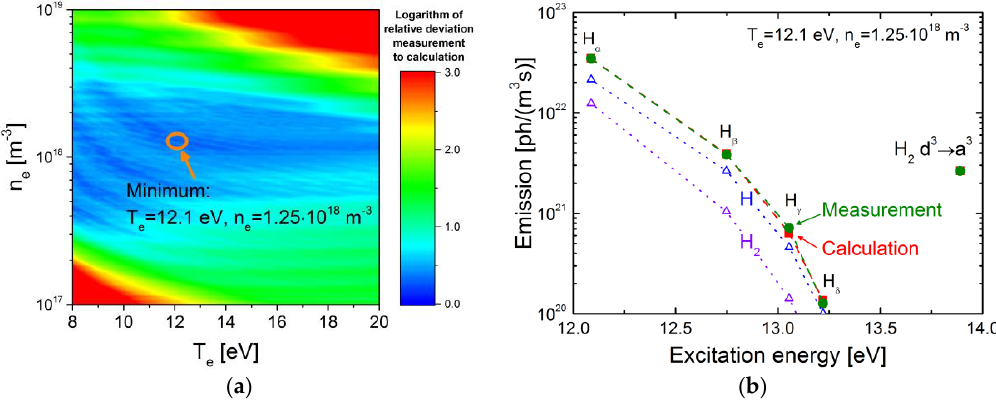
Figure 4. Comparison of Yacora CR model results with the Balmer line emission and the emission of the molecular band d 3 → a 3 measured in an ionizing plasma: ( a ) 2D matrix illustrating a parameter space in T e and n e the best possible agreement between measurement and model; ( b ) comparison of the measured emission vs model results for T e = 12.1 eV and n e = 1.25 × 10 18 m −3 (depicted by the orange ellipse in Figure 4a). Additionally, shown are the calculated fractions of emission that can be attributed to direct excitation of H and from dissociative excitation of H 2 .